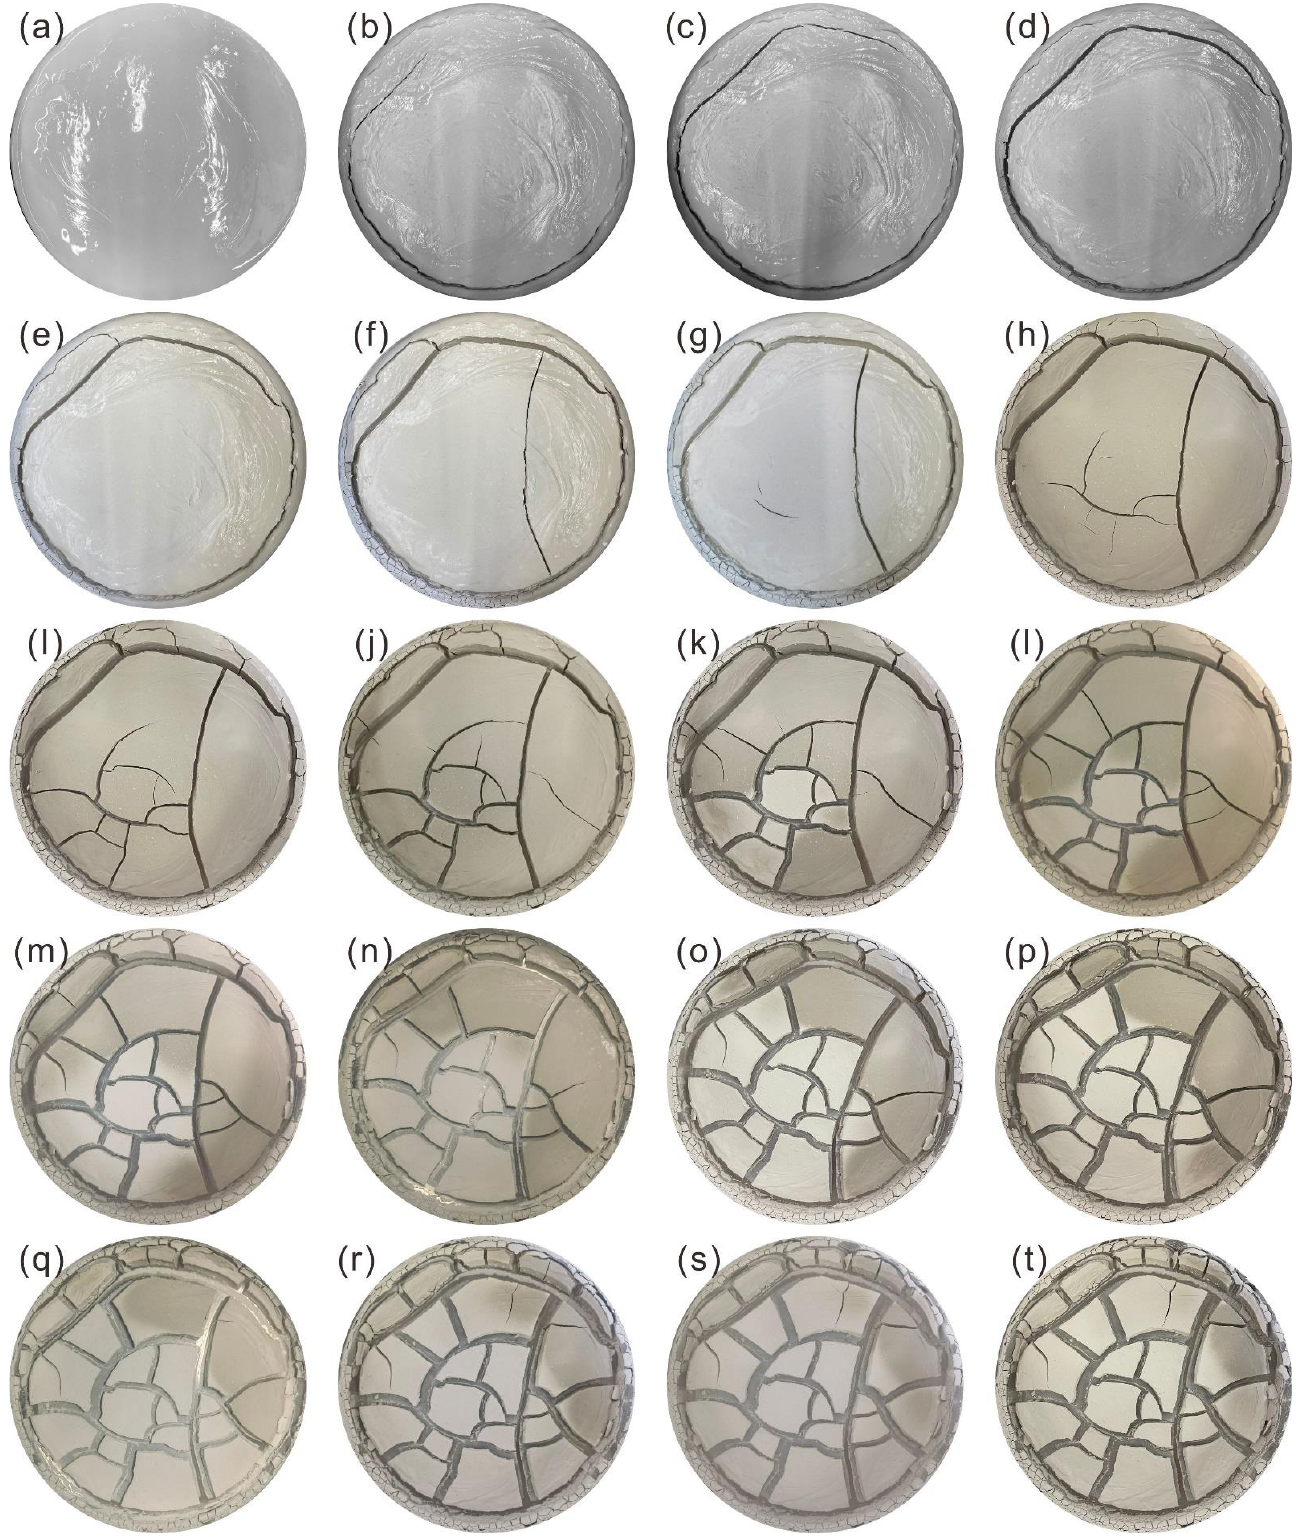
Figure 3. Crack development process of S2. The time between ( a ) and ( b ) is 31 h. The time between adjacent pictures is 4 h. The diameter of the sample is 24 cm. After ( t ), cracks stopped developing.( a ) – ( t )